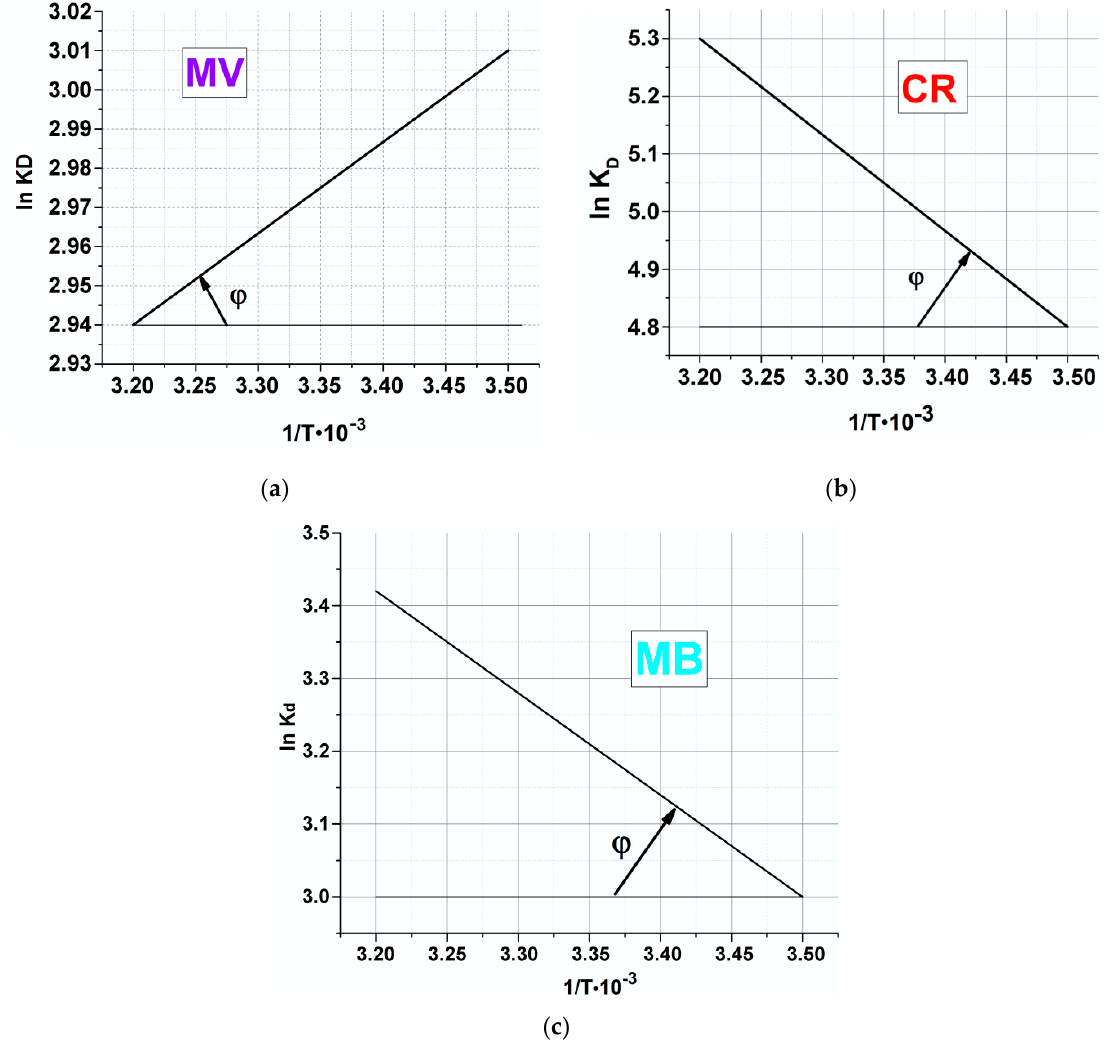
Figure 9. Plot of lnK versus 1/T for estimation of thermodynamic parameters for MV( a ), CR ( b ), and MB ( c ) and adsorption onto Cu 3 (BTC) 2· 2H 2 O.